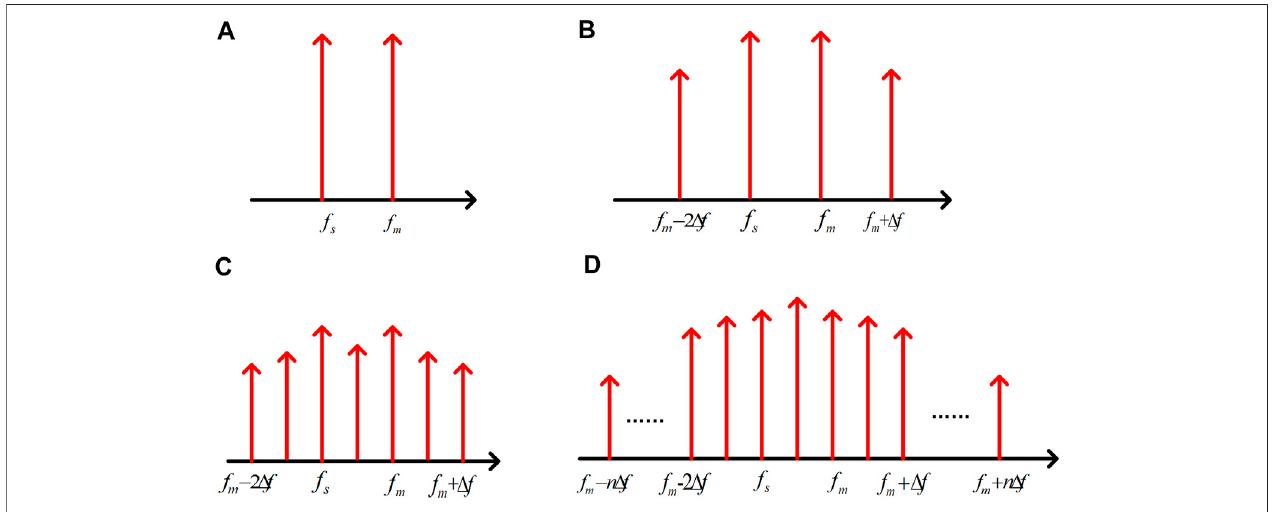
FIGURE 1 | Principle diagram of the proposed generation system of the OFC. Spectra diagram of (A) free-running ML and SL lasers, (B) primary seed OFC, (C) subharmonic-locked OFC, and (D) FMW-broadened OFC.